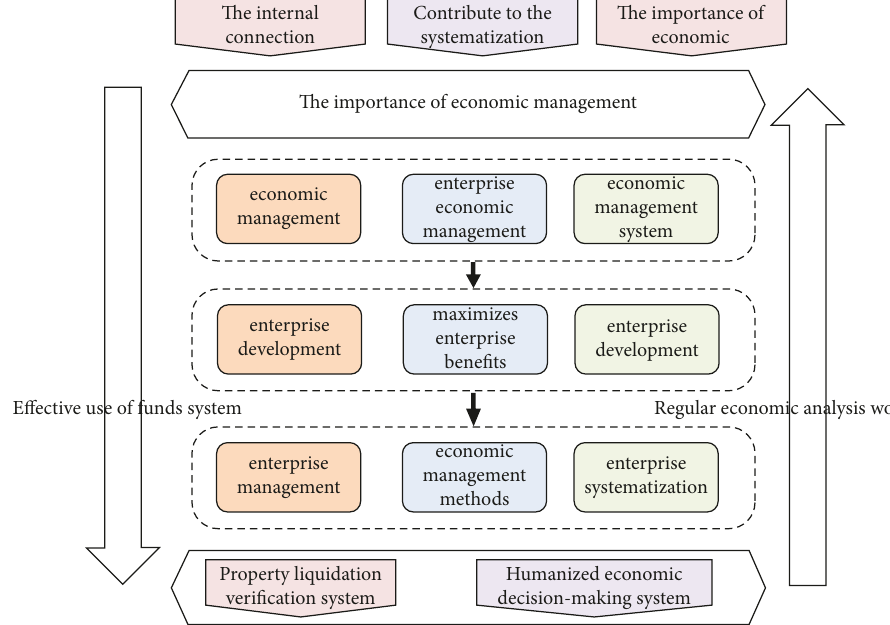
Figure 1: The overall framework of enterprise economic management